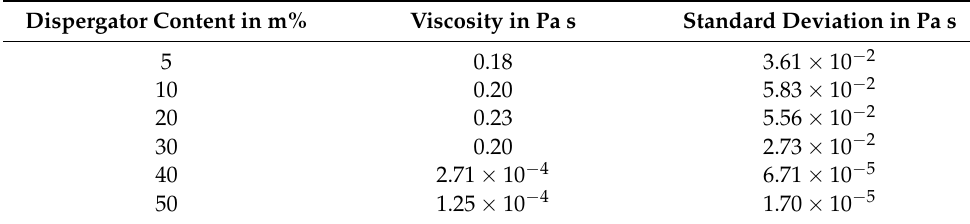
Table A12. Viscosity values as a function of TX-100 content for an aqueous dispersion containing 10 m% graphite nanoparticles at a pH value of 10.75–11.